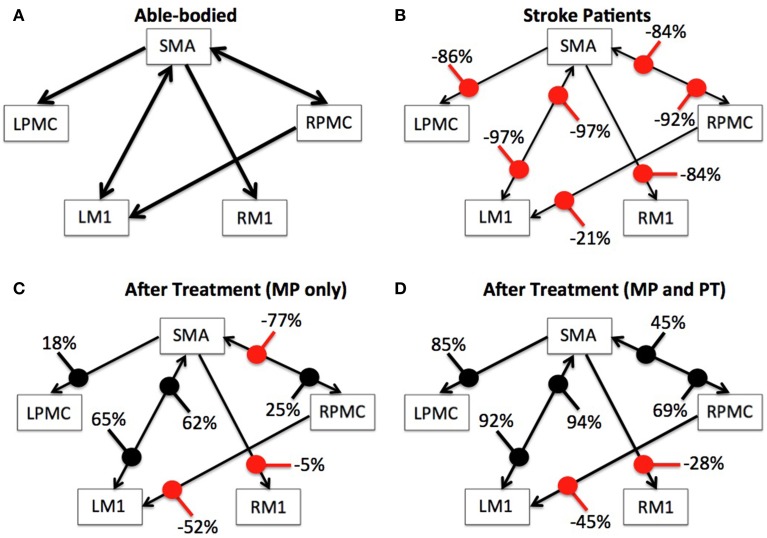
Percent difference and modulation. Compared to (A) able-bodied participants, percent decrease of the causal flow ranged from −21 to −97% for aged stroke patients as shown in (B), whereas compared to these stroke patients, there was a percent modulation ranging from −77 to 65% for stroke patients who underwent MP as shown in (C) and from −45 to 94% for stroke patients who underwent MP+PT as shown in (D). Percent decrease and percent modulations are shown with red and black colored dots respectively. Width of the arrows represents corresponding strength of connections on an arbitrary scale. Wider the arrows, stronger are the connections.